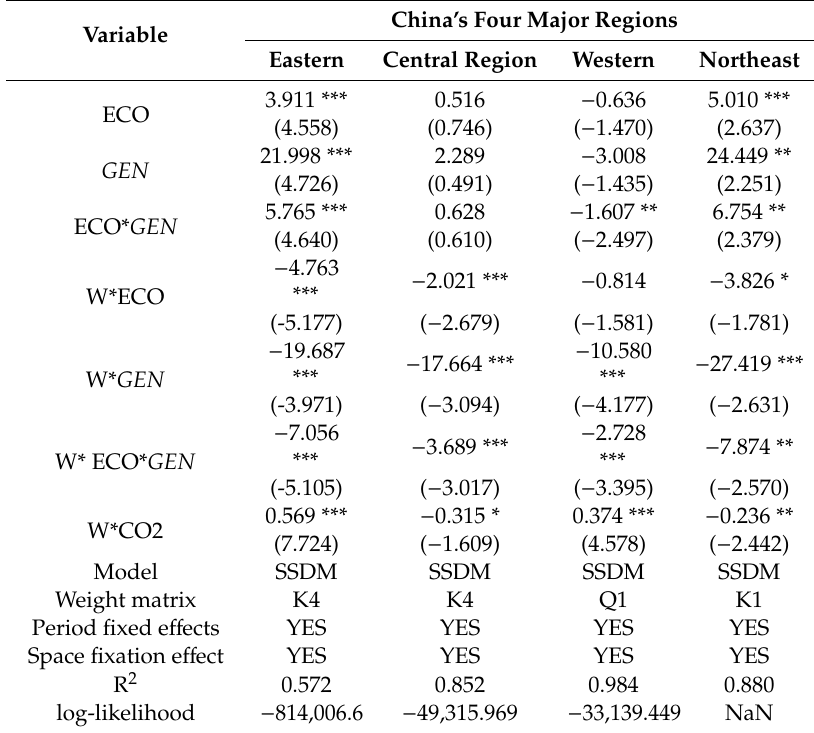
Table 9. Impact of ECO on carbon emissions: regional